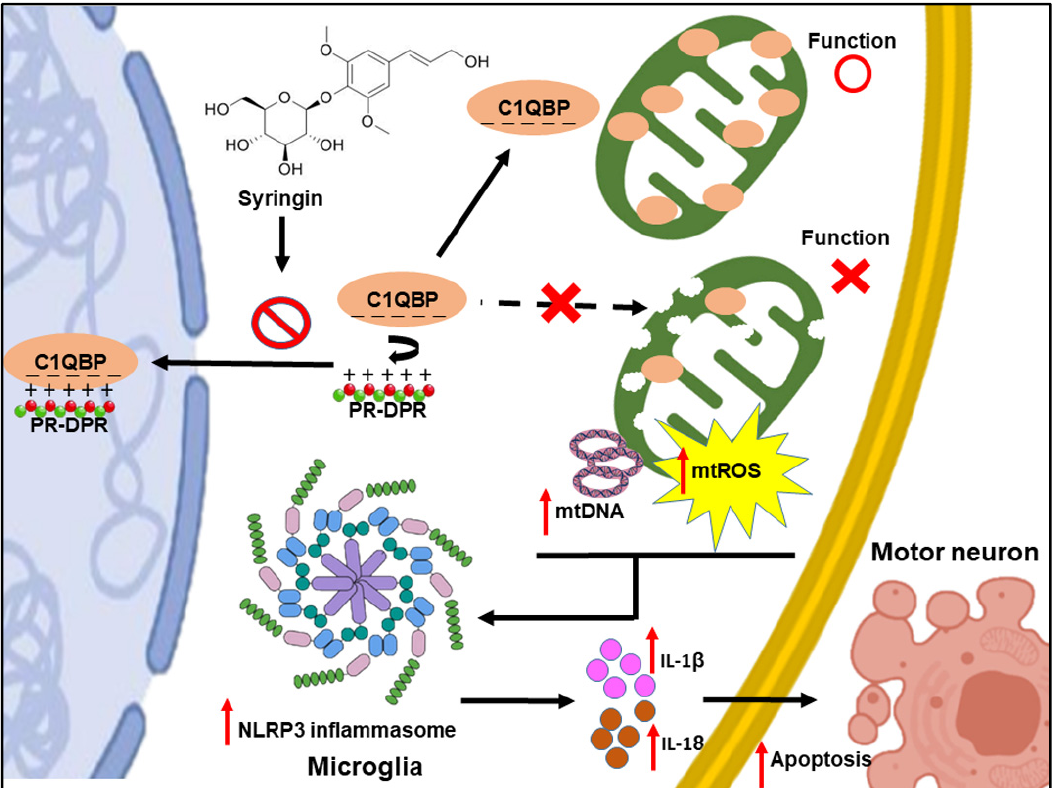
Figure 11. PR 50 binds C1QBP and inhibits its function, resulting in mtROS production and mtDNA escape. Finally, NLRP3 inflammasome activity in microglia is induced. Syringin (SRG) treatment reduced the interaction between C1QBP and PR 50 , and hence attenuated PR 50 -induced NLRP3 inflammasome activity in microglia as well as PR-CM-caused apoptosis in motor neuron cell. According to our study, inhibiting the interaction between PR-DPR and C1QBP in